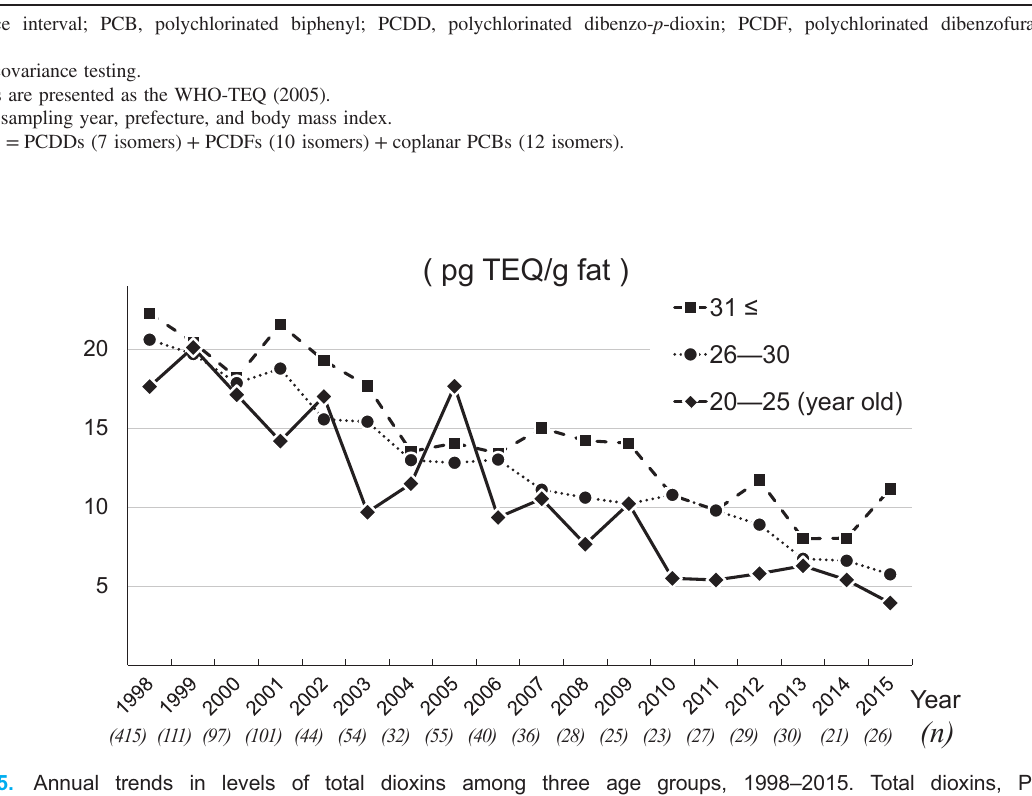
Figure 5. Annual trends in levels of total dioxins among three age groups, 1998 – 2015. Total dioxins, PCDDs (7 isomers) + PCDFs (10 isomers) + coplanar PCBs (12 isomers). Annual levels of total dioxins among three age groups are shown with the means during the study period (1998 – 2015). Each value given in parentheses under the calendar year represents the sample size in each